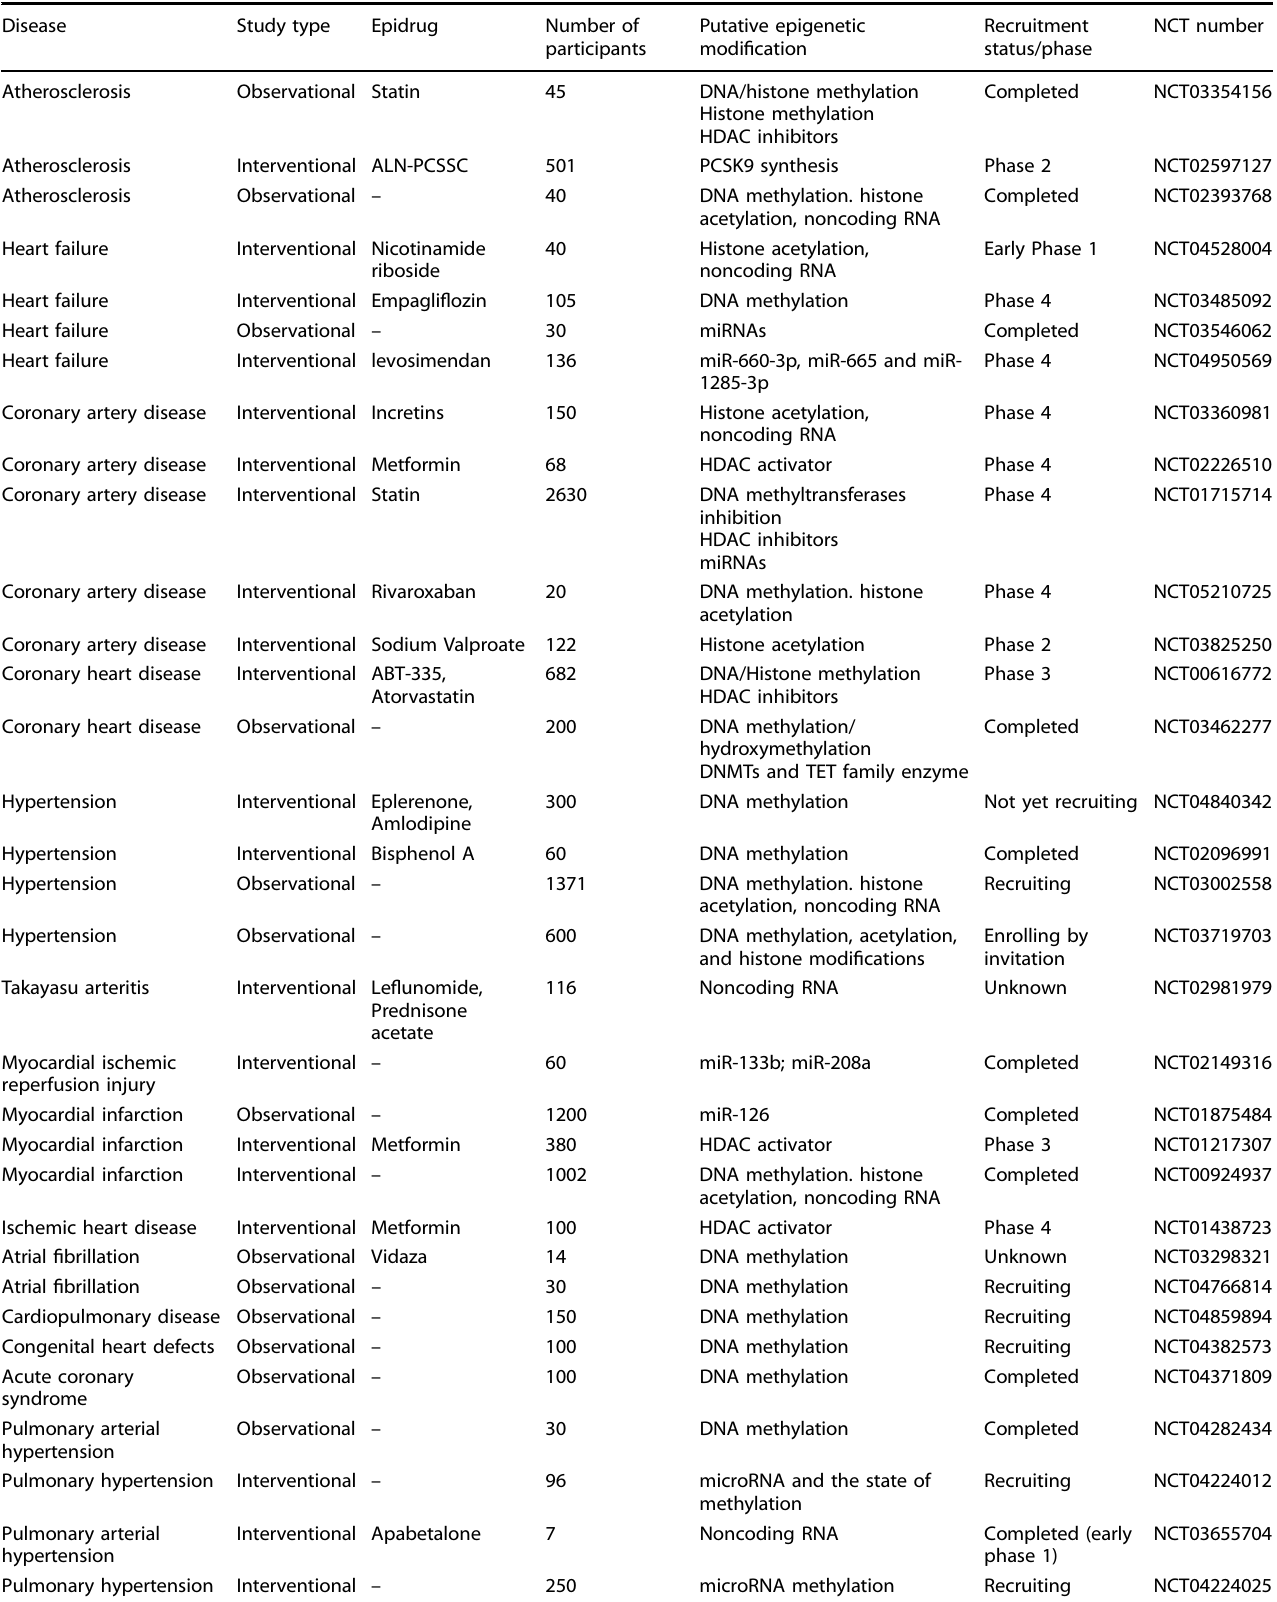
Table 6. Clinical Trials With Epigenetics-Based cardiovascular disease Therapeutics